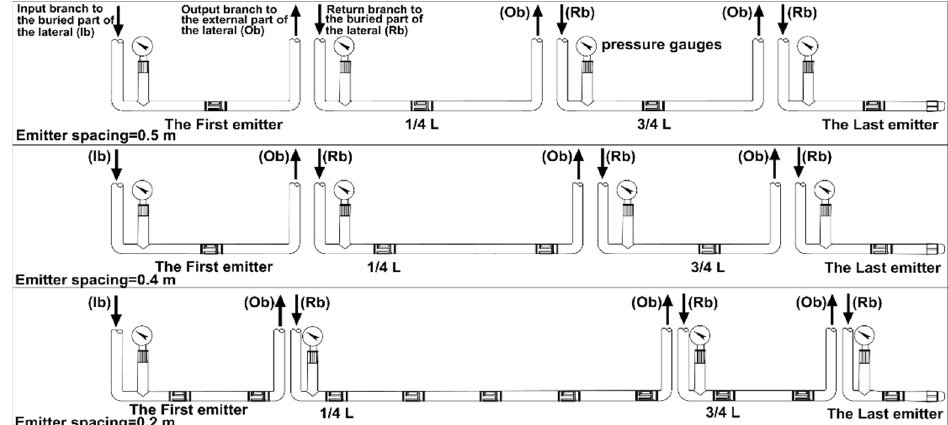
Figure 3. Planar view of the input, output, return branches, and the emitter positions in the buried part of the three drip laterals at the 0.2 m depth in the soil box.